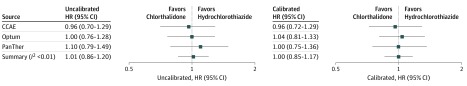
Homogeneity on EffectivenessHazard ratios (HRs) and forest plot of the 3 databases and the meta-analysis for chlorthalidone vs hydrochlorothiazide on the composite cardiovascular disease outcome. The 3 databases showed excellent agreement. CCAE indicates Commercial Claims and Encounters Database.